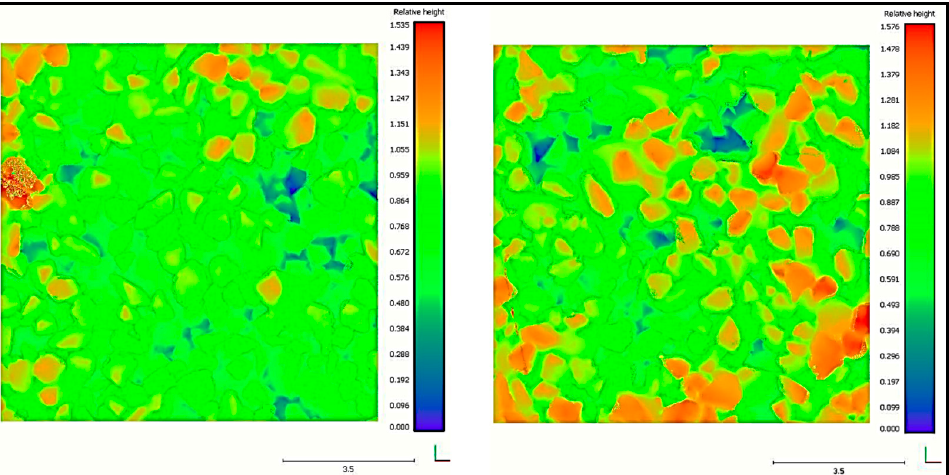
Figure 12. Height maps obtained from the 3D scans of the area subjected to APT loading (left) and the adjacent section (right) that received no loading .